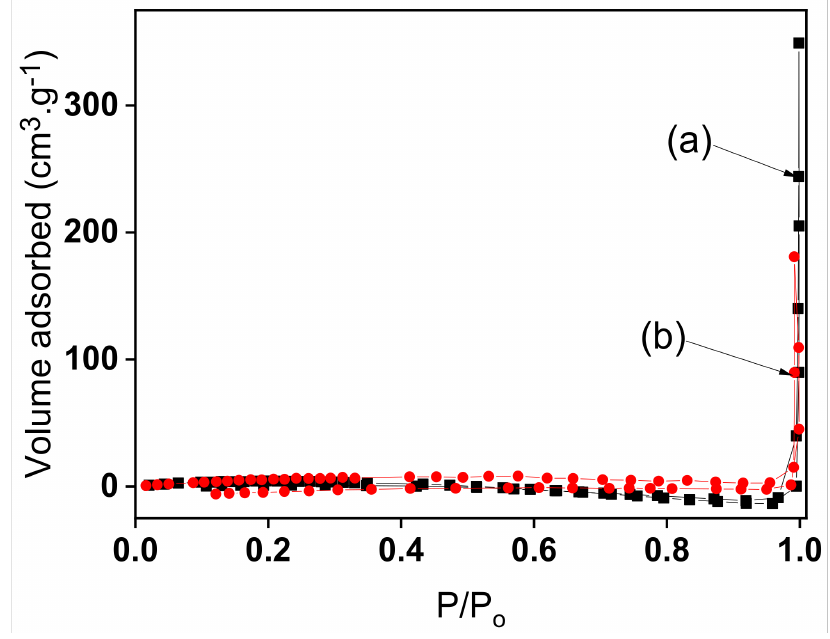
Figure 1. N 2 sorption isotherms (at 77.13 K) for ( a ) Nat-Talc, and ( b ) TalcNH 2